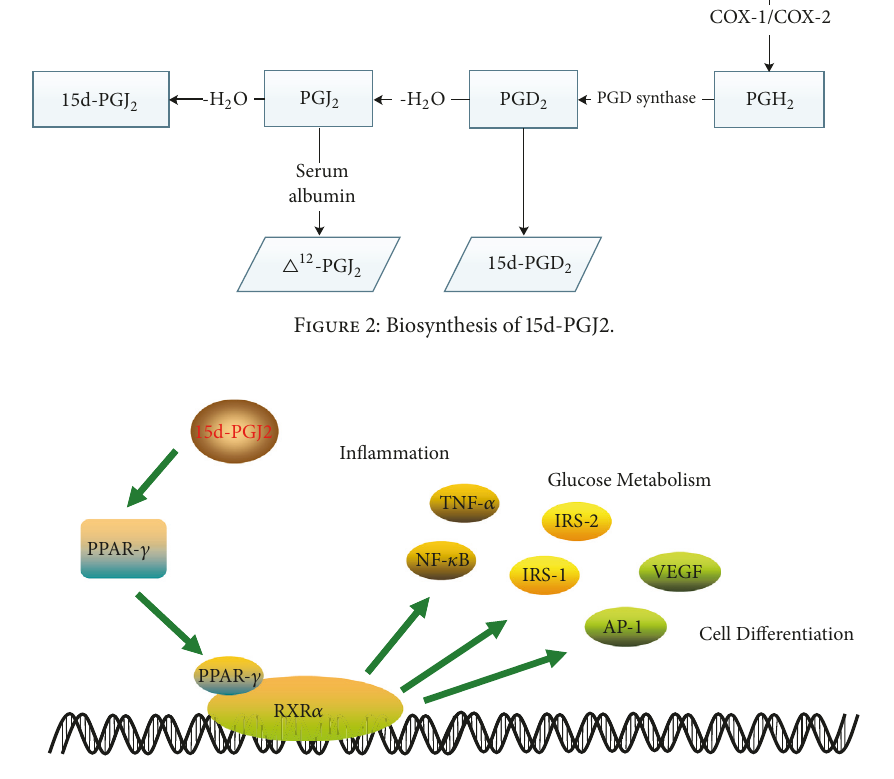
Figure 3: Regulation of PPAR- 𝛾 by